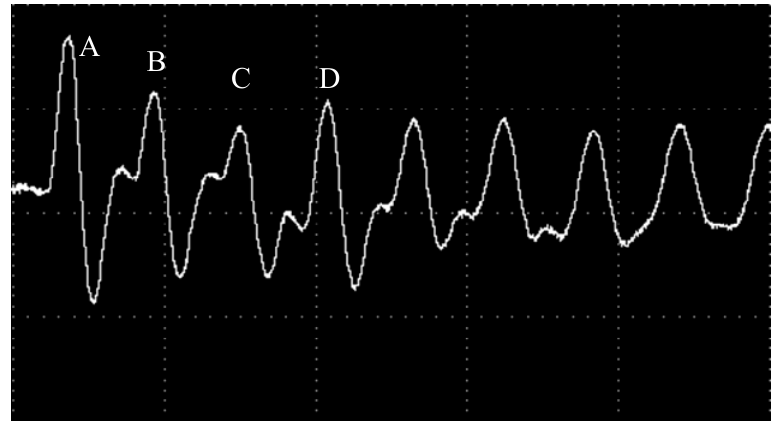
Figure 14. The piezoelectric waveform of shock waves that are formed by the laser’s 1064 nm wavelength inducing silicon’s target surface.